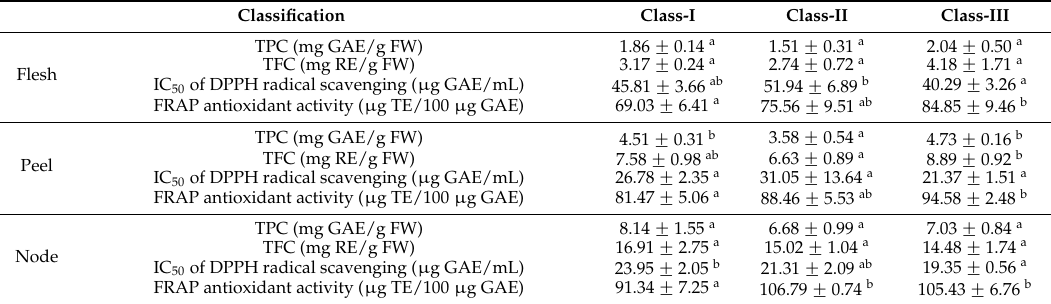
Figure 1. Hierarchical cluster diagram of lotus root varieties based on the content and antioxidant activity of phenolic compounds. Table 7. Phenolic contents and antioxidant activities of three classes of lotus